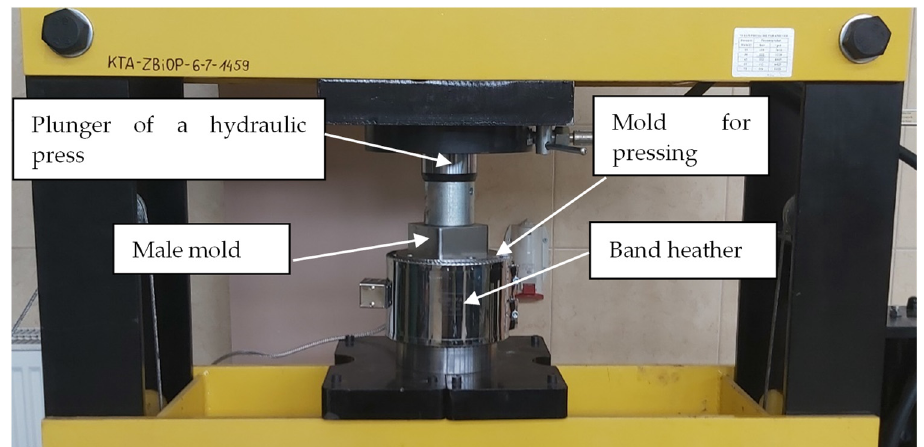
Figure 1. Stand for manufacturing composite samples.